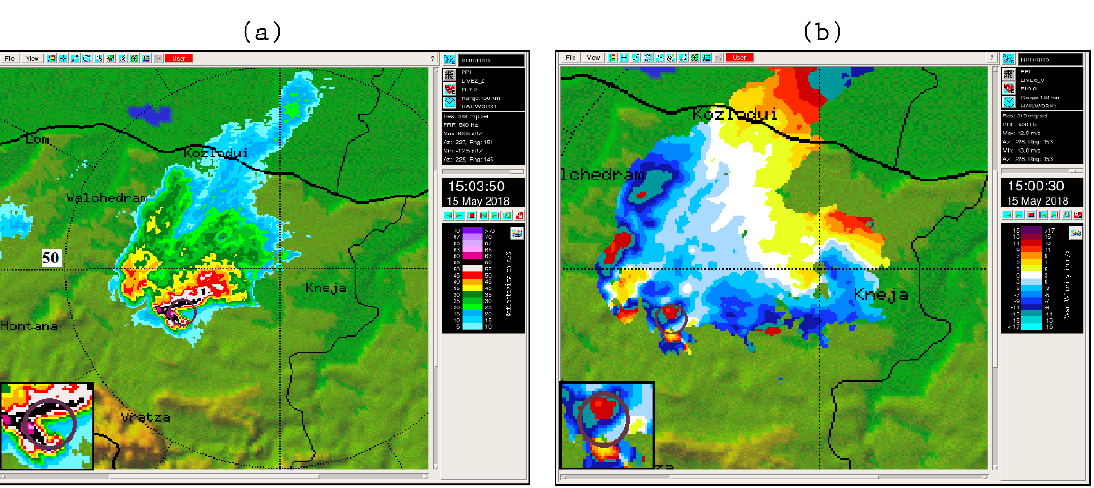
Figure 5. PPI radar images of the supercell at 13:00 UTC showing ( a ) a hook-like reflectivity signature resulting from the mesocyclonic circulation at a 7 ◦ elevation angle and ( b ) Doppler velocities within the supercell at a 9 ◦ elevation angle. The mesocyclonic rotation is highlighted with a black circle and further zoomed into through the inlet at the bottom left-hand side of the panels.